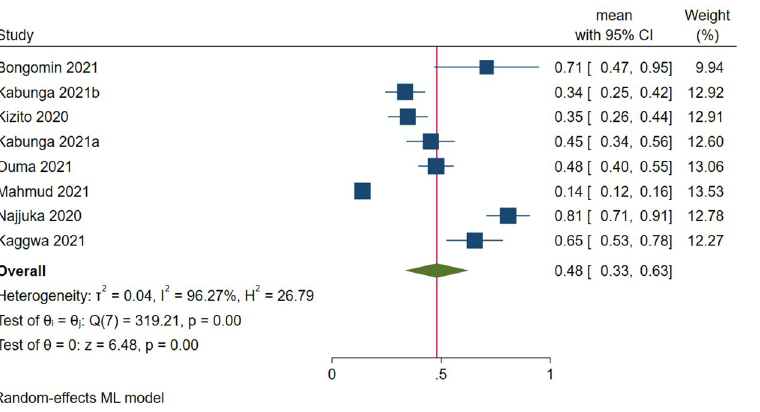
Fig 3. Forest plot on the prevalence of depression during the COVID-19